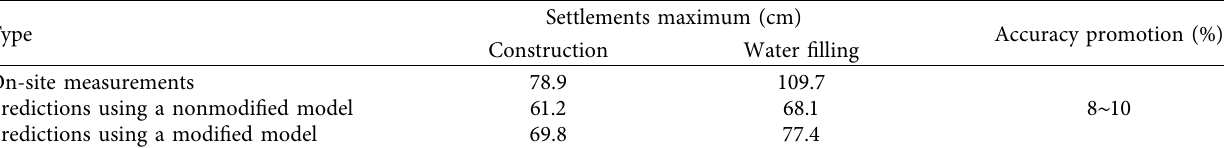
Table 13: Comparison between calculated and measured dam